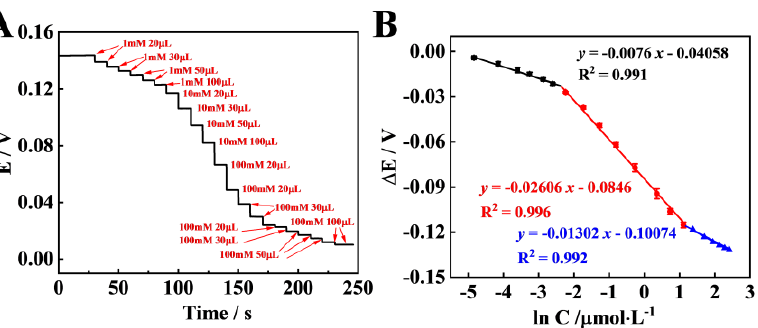
Figure 4. ( A ) Potential responses of the Dy − OSCN/FTO electrode at different concentrations of AA in the range of 7.94 µ M to 13.71 mM; ( B ) the corresponding linear calibration curve for AA detection. The detection limit (LOD) could be estimated to be 3.35 µ M. The results indicated that the constructed Dy-OSCN/FTO electrode showed good PEC performance and high sensitivity.